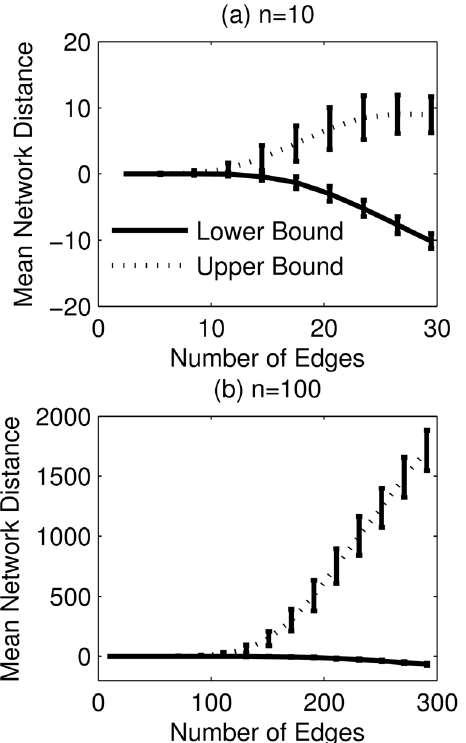
Figure 4. Ensemble inference and inferability of 10 , 000 random networks of order (a) n ~ 10 and (b) n ~ 100 genes. The mean network distances of the lower and upper bounds from G 6 0 are shown as a function of network size (i.e. number of edges). The error bars indicate the standard deviations.